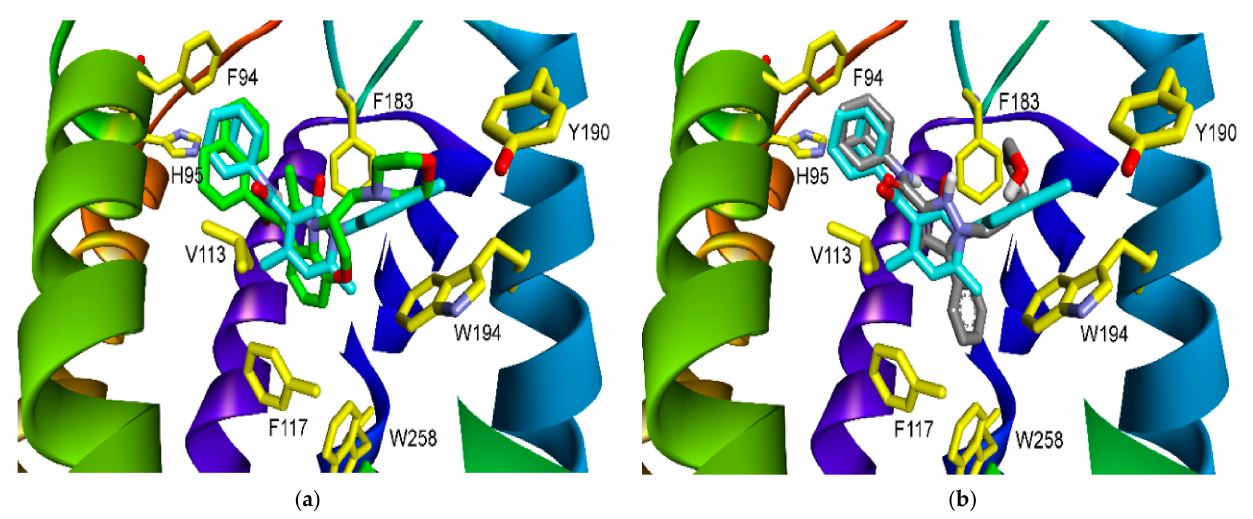
Figure 6. ( a ) Superposition of docked 8d (cyan) with bound agonist WIN 55,212-2, (green) in the activated CB2R complex (residues in yellow); ( b ) Superposition of docked 8d (cyan) with bound antagonist AM10257, (gray) in the activated CB2R complex (residues in yellow).